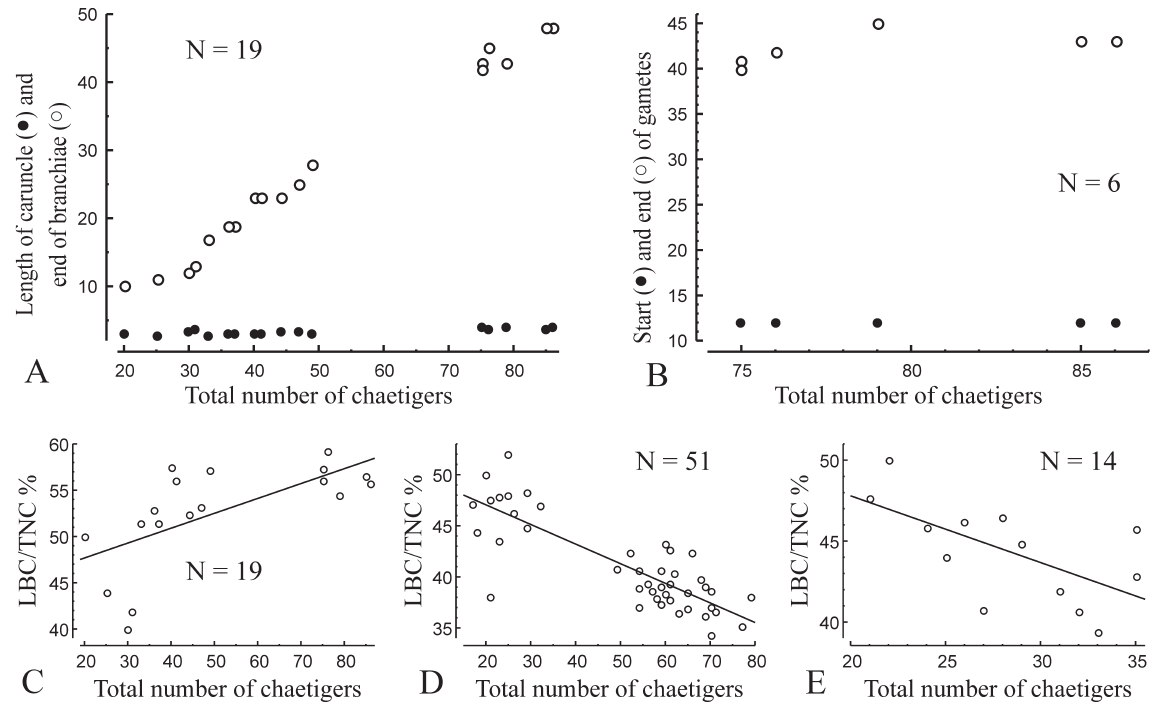
Fig. 5. Adult characteristics of Pseudopolydora spp. from the Arabian Gulf, Kuwait. A–C . Pseudopolydora antennata (Claparède, 1868). D . P. arabica Radashevsky & Al-Kandari, 2020. E . P. kuwaiti sp. nov. A . Relationships between caruncle length (in chaetiger numbers) and total number of chaetigers, and between distribution of branchiae (referring to number of the last branchiate chaetiger) and total number of chaetigers. B . Relationships between distribution of gametes (referring to number of the first and the last chaetigers with gametes) and total number of chaetigers. C–E . Relationships between distribution of branchiae (referring to number of the last branchiate chaetiger LBC divided by the total number of chaetigers TNC) and total number of